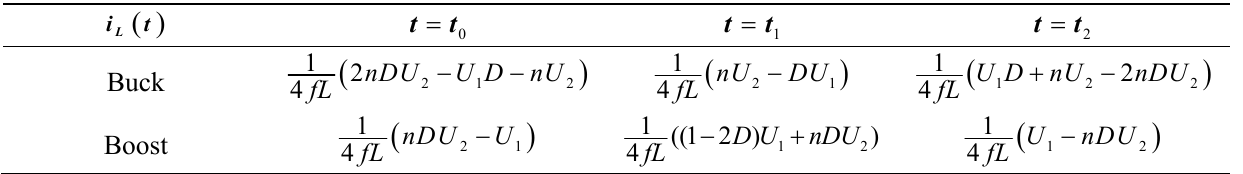
Table 1. The instantaneous currents of leakage inductance with ESPS control.